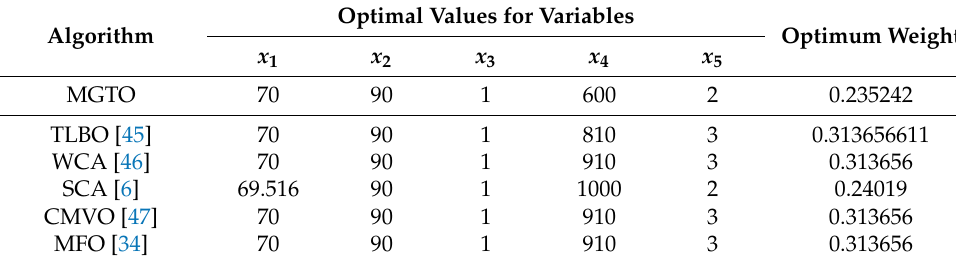
Table 14. Experimental results of the multiple disc clutch brake problem